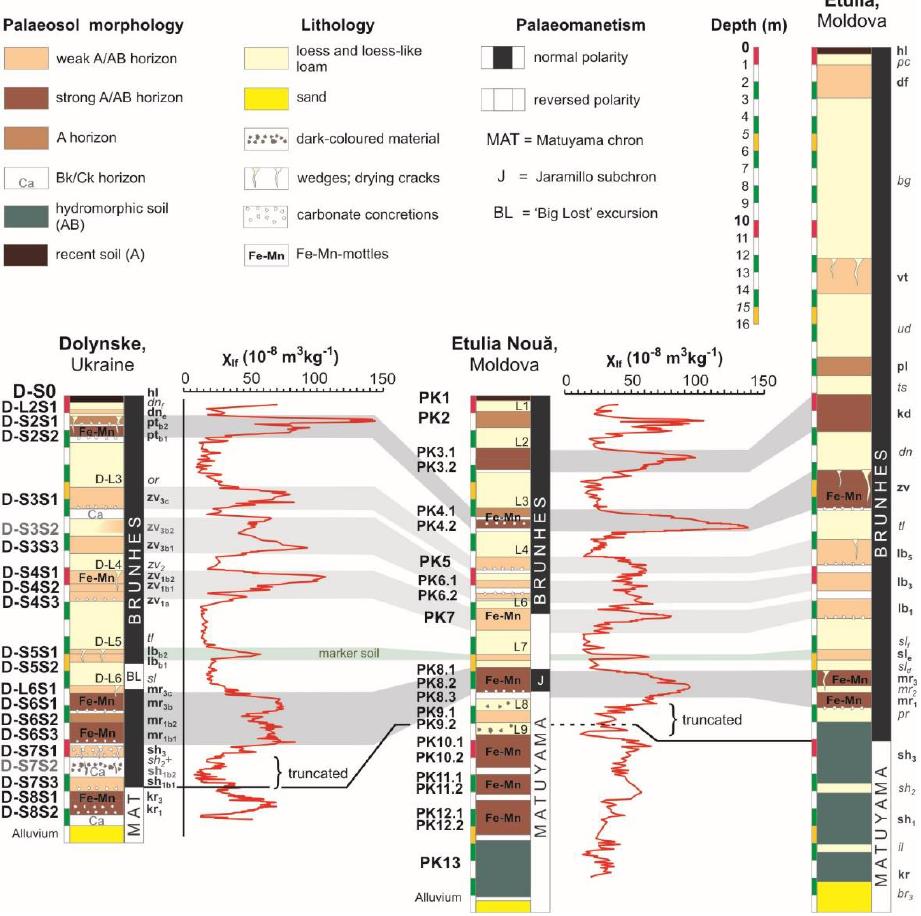
Figure 8. Correlation between loess –palaeosol sequences of Dolynske (this study), Etulia Nouă, adapted with permission from Tsatskin et al. [215], Elsevier, 2001, and Tsatskin et al. [216], Springer Nature, 2008, and Etulia, modified from Veklich and Veklich [214].